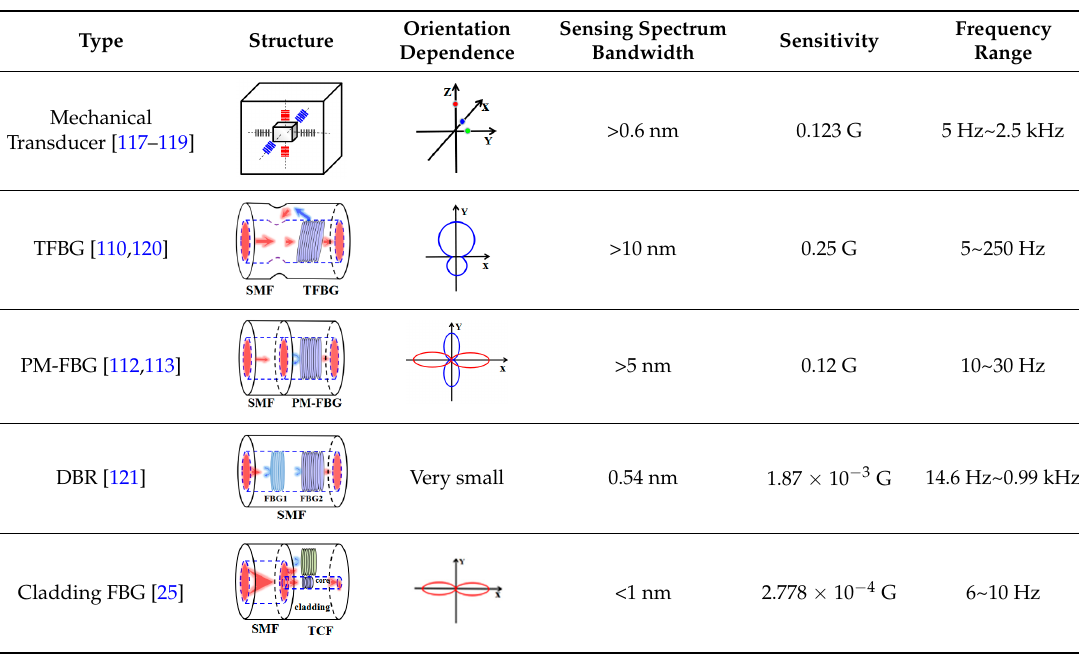
Figure 6. ( a ) Cross-sectional photomicrograph of the MCF-FBG; ( b ) Refractive index profile of the MCF-cross section; ( c ) Longitudinal photomicrograph of gratings inside MFC; ( d ) Schematic of the vector grating; ( e ) Spectra of the vector-FBG; ( f ) Angular dependence of acceleration responsivity of this sensor. Table 1. FBG basedaccelerometers.